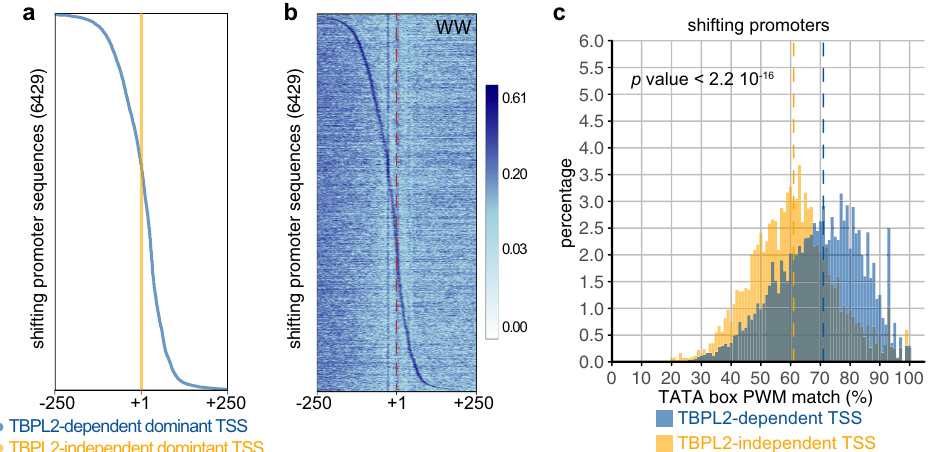
Fig. 6 Shifting promoters. a , b Analysis of the TBPL2-dependent versus TBPL2-independent shifting promoters within a − 250/ + 250 region centred on the position of the TBPL2-independent transcription start sites (TSS) clusters (position + 1 in ( a , b ) and red dashed line in ( b )). Position of the TBPL2- dependent (blue) and of the TBPL2-independent (orange) dominant TSSs for each shifting promoter sequence ( a ) and WW dinucleotide enrichment heatmap ( l ) from the same set of sequences ordered as in ( b ). c Distribution of the best TATA box PWM matches within a − 35 to − 20 region upstream of the TBPL2-dependent (blue) and TBPL2-independent (orange) dominant TSS of the shifting promoters. The dashed lines indicate the median of the TATA box PWM matches for the TBPL2-dependent (blue) and the TBPL2-independent (orange) shifting TSS clusters ( P value after a two-tailed Wilcoxon rank- sum